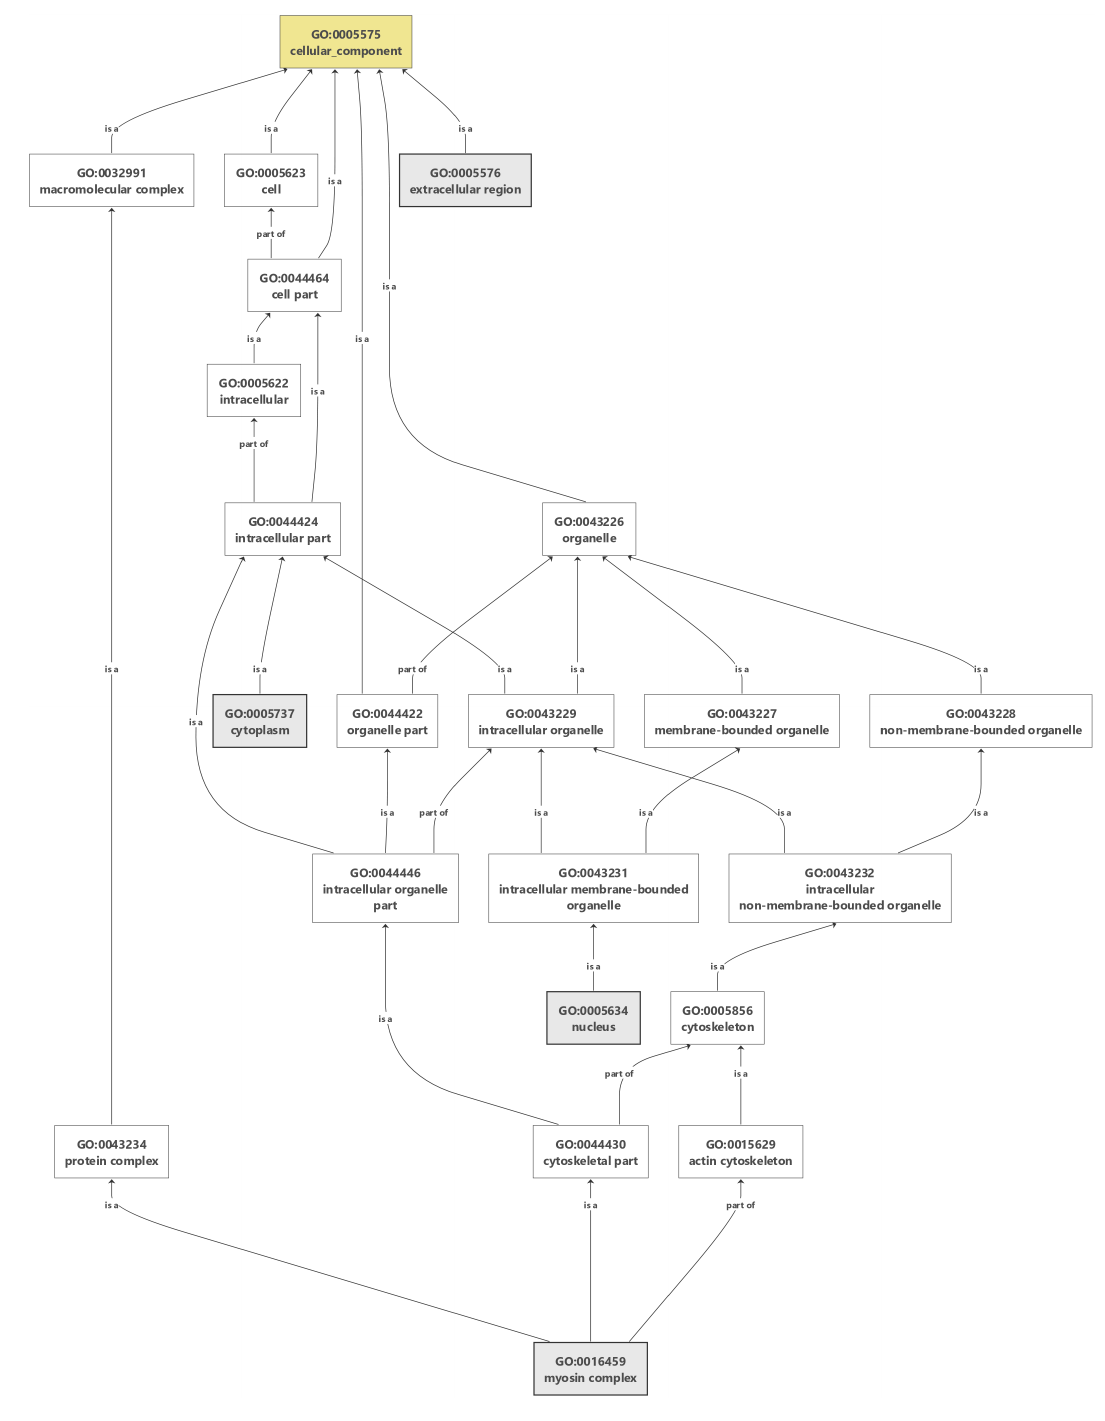
Figure 2. Gene ontology of cellular components for growth traits in